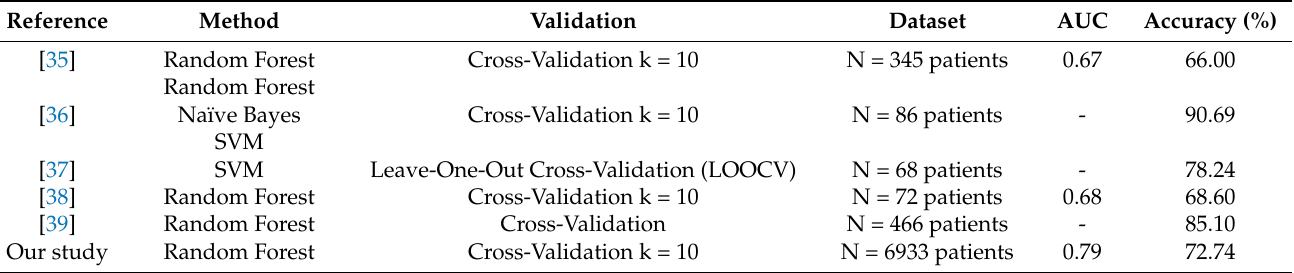
Table 5. Comparison of results obtained with other